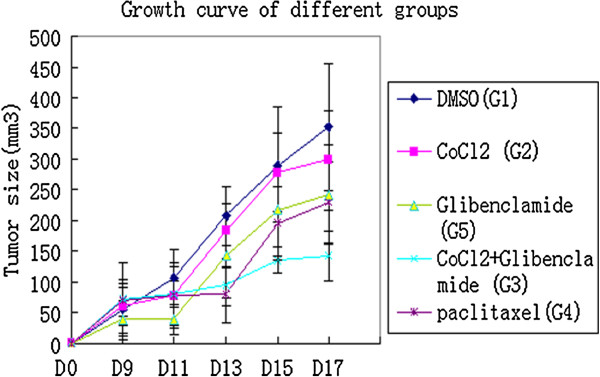
The growth curve of injected TA2 breast cancer cells in the control and treatment groups.